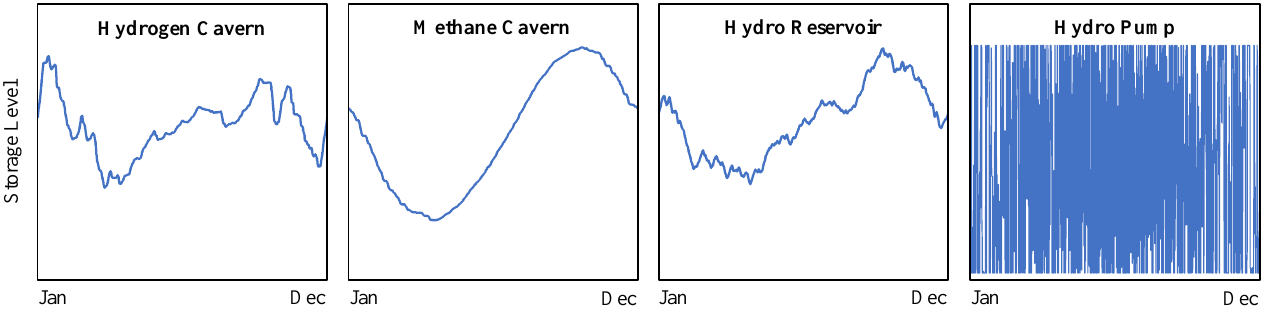
Figure 4. Annual storage levels for different storage technologies (model result).